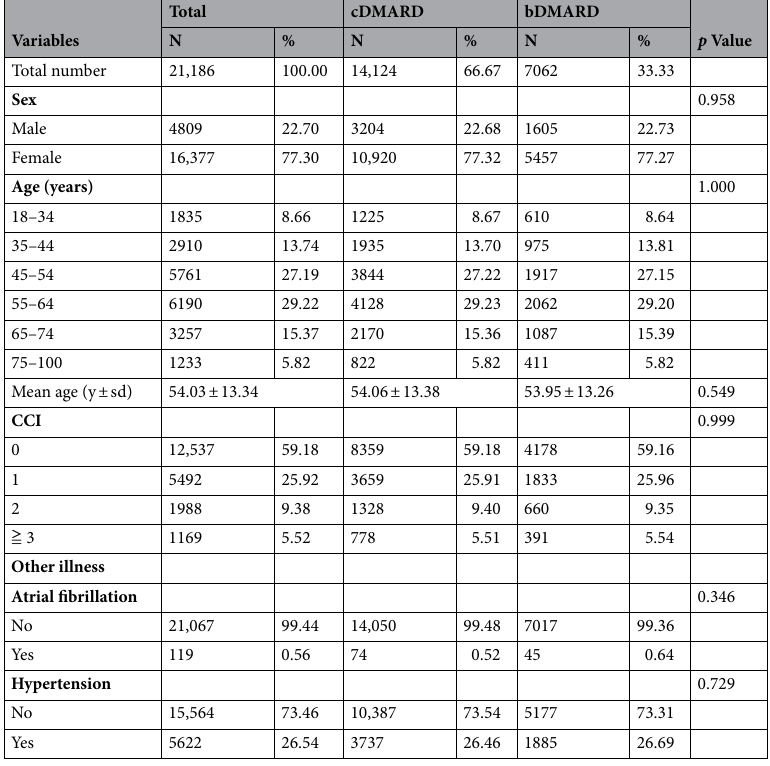
Table 2. Analysis of RA patients using different DMARDs by propensity score matching. N = number, y = years, sd = standard deviation, NT dollars = New Taiwan dollars. CCI is Charlson Comorbidity